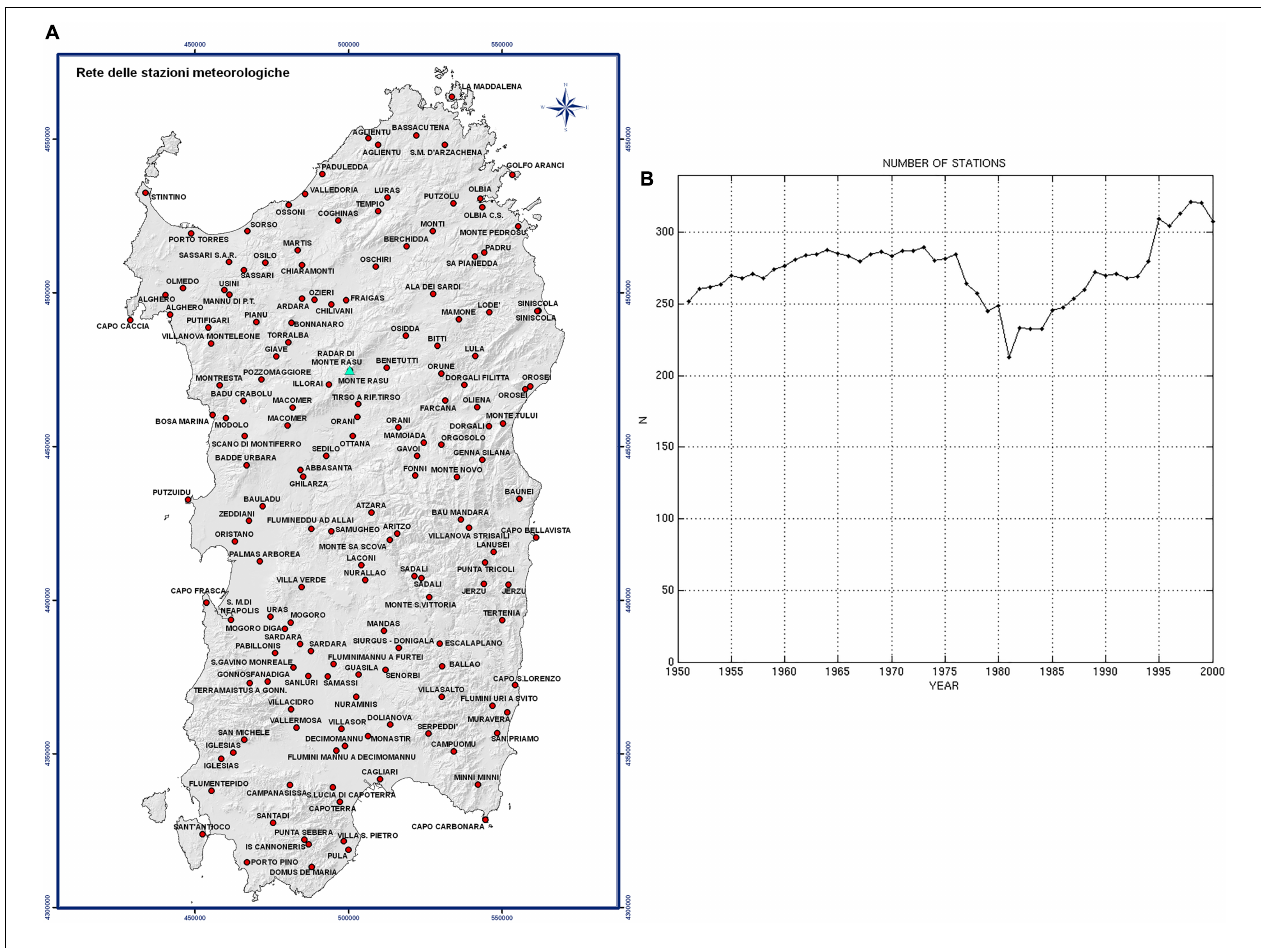
FIGURE 6 | (A) Sardinia map with stations network. (B) Number of